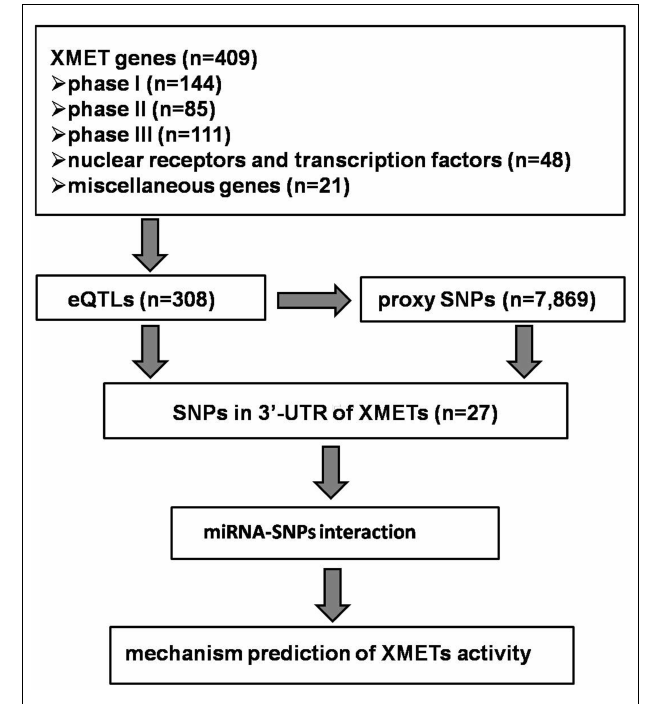
FIGURE 1 | Schematic of the search for miRNAs and the associated SNPs from XMET